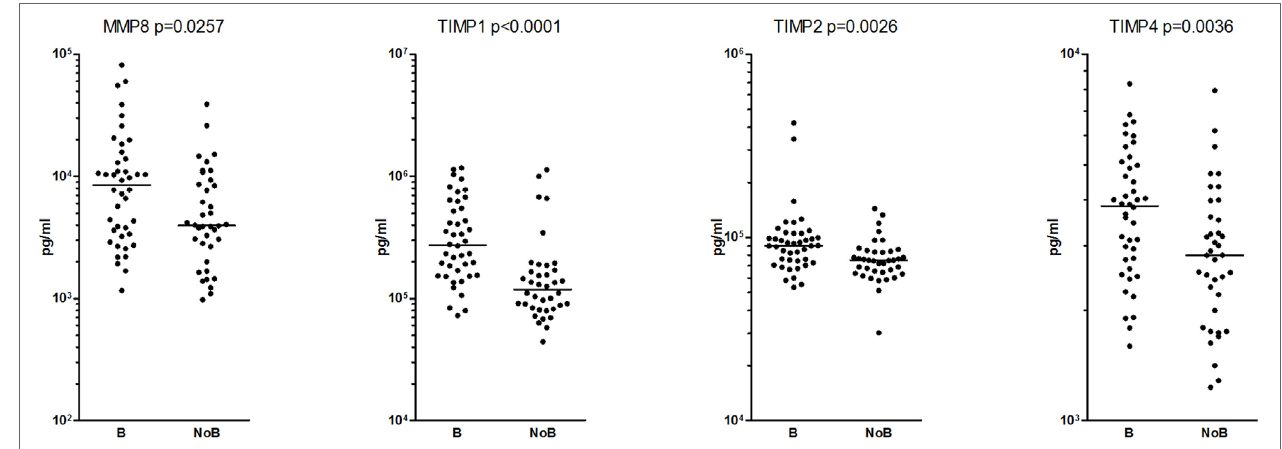
FigUre 2 | The mediators with significant differences between the patients with (B) and without (NoB) bacteremia are presented and each dot represent one patient. The Mann–Whitney U test was used for the comparisons, p < 0.05 were regarded as significant and p < 0.0014 were also significant after Bonferroni